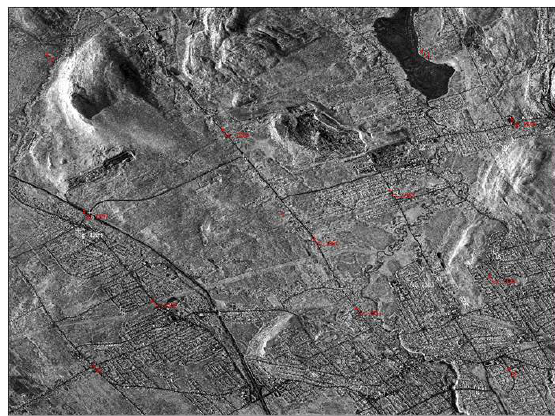
Figure 5: GCPs distribution on COSMO-SkyMed imagery